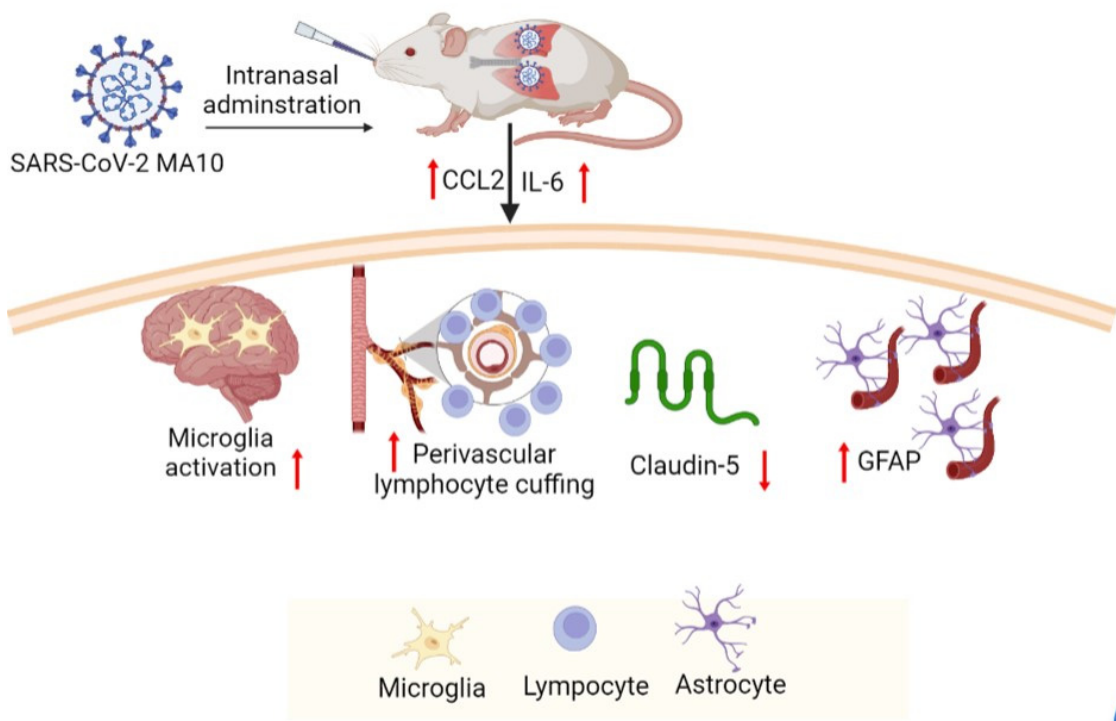
Figure 6. Intranasal administration of SARS ‐ CoV ‐ 2 (MA10) upon accumulation in the mice upregulates Ccl2 and Il ‐ 1 β , activates microglia, induces perivascular lymphocyte cuffing, promotes astrocyte accumulation, triggers a loss of tight junction protein claudin ‐ 5. These neuroinflammatory events mediate cerebrovascular pathology in the mice infected with SARS ‐ CoV ‐ 2 (MA10). (https://biorender.com/accessed on 30 October 2022).